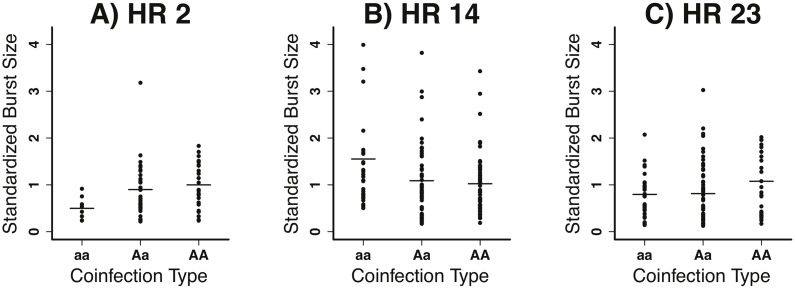
Burst size measures for homozygous mutant (aa), heterozygous (Aa) and homozygous wildtype (AA) coinfections are shown as columns of points and their means are show as lines.Two of the host range mutants (HR2 and HR23) did not have mutations in P3, but differences in their mean homozygous effects suggest that they are different mutations.